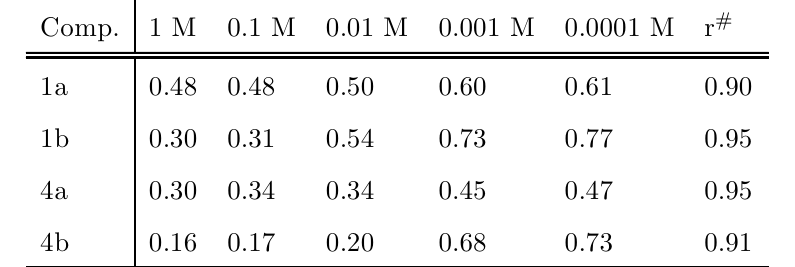
Table 6 R f values of compounds 1a,b and 4a, b at various acidities ¤ RPTLC plates Merck RP-18 F 254 s; mobile phases ethanol / hydrochloric aqueous acid